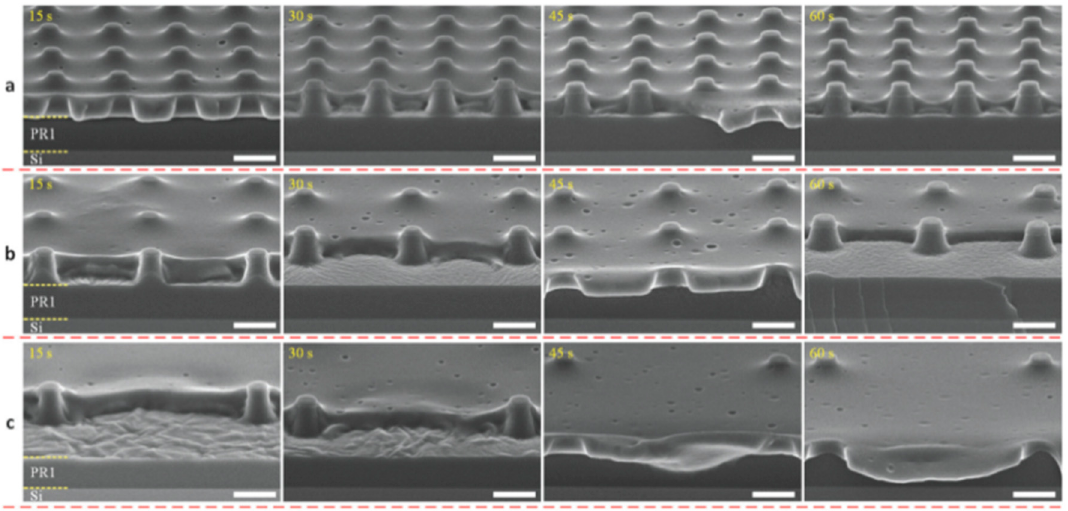
Figure 18. Cross-section HR-SEM images of the PDMS-coated PR column arrays with different pitches of: ( a ) 3 µm, ( b ) 5 µm, and ( c ) 10 µm with various etching times, adapted from [34] .